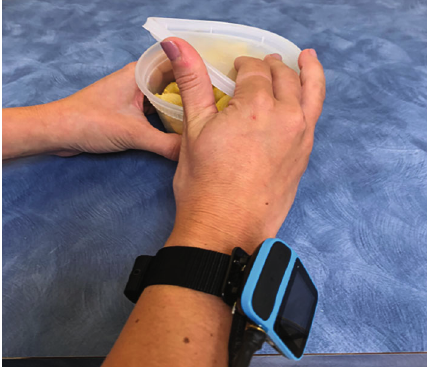
Figure 1: TheraBracelet worn on paretic wrist during task